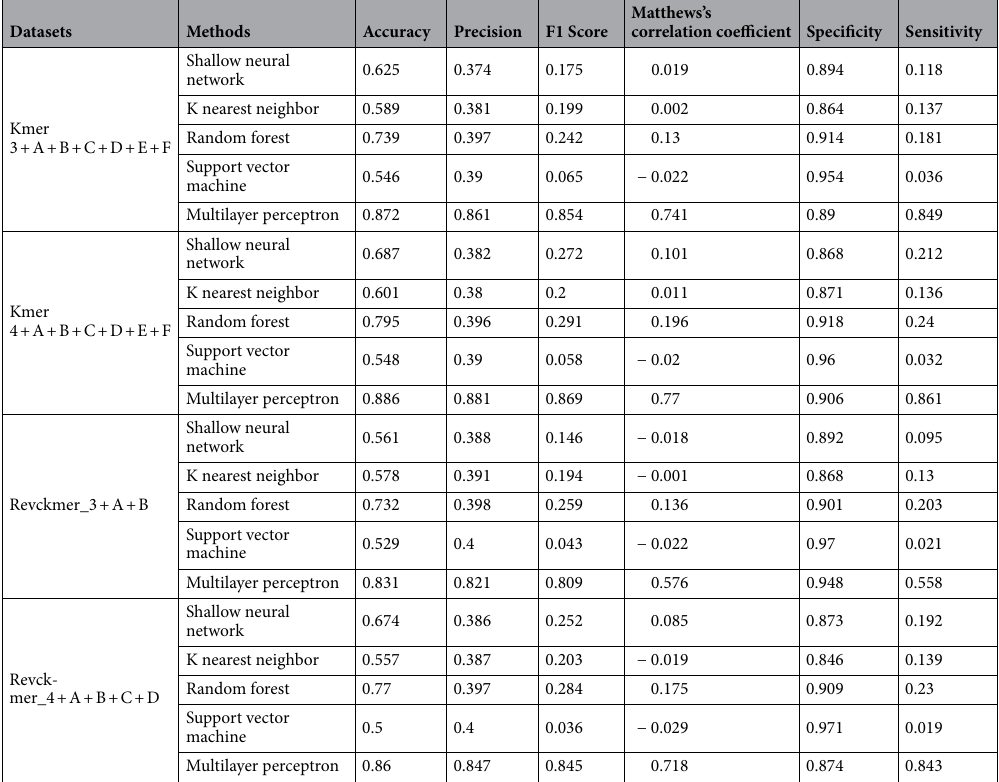
Table 3. The average performances of our model with four machine learning algorithms on four different datasets. Where Kmer 3 is 3mer frequency, Kmer 4 is 4mer frequency, Revckmer 3 is reverse complement 3mer, and Revckmer frequency 4 is reverse complement 4mer frequency for aptamer properties. For protein properties: A indicates hydrophobicity, hydrophilicity, and mass; B indicates polarity, molecular weight, and melting point; C indicates transfer free energy, buriability, and bulkiness; D indicates solvation free energy, relative mutability, and residue volume; E indicates volume, amino acid distribution, and hydration number; F indicates isoelectric point, compressibility, and chromatographic